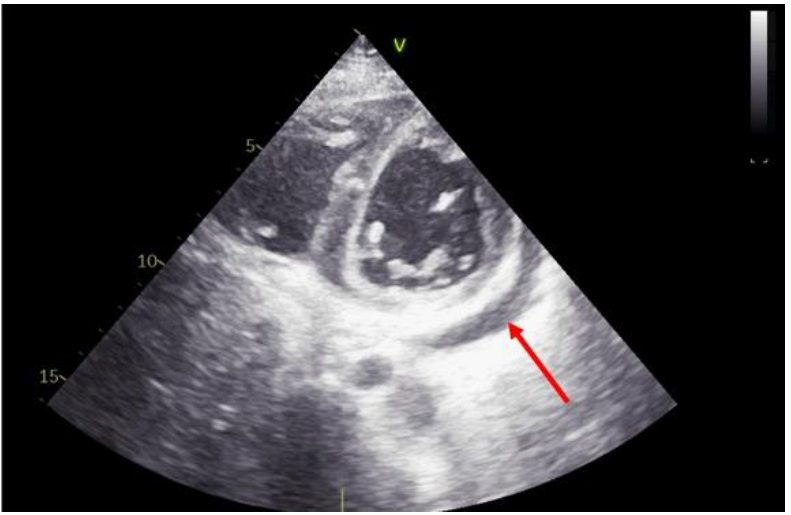
Figure 3. Short-axis view at trans thoracic echocardiography, one month after heart transplantation. Note the small pericardial effusion in the lateral position (red